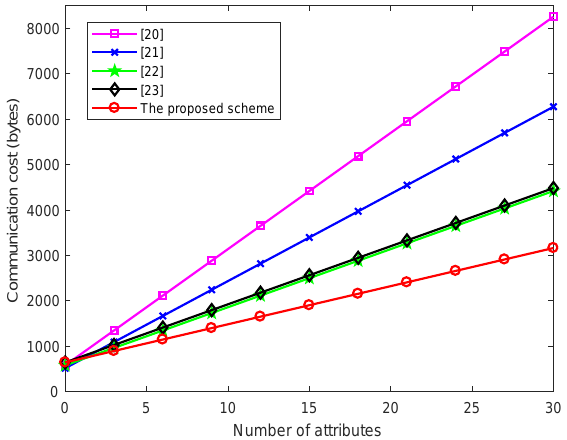
Figure 6. Unsigncrypt cost with the number of